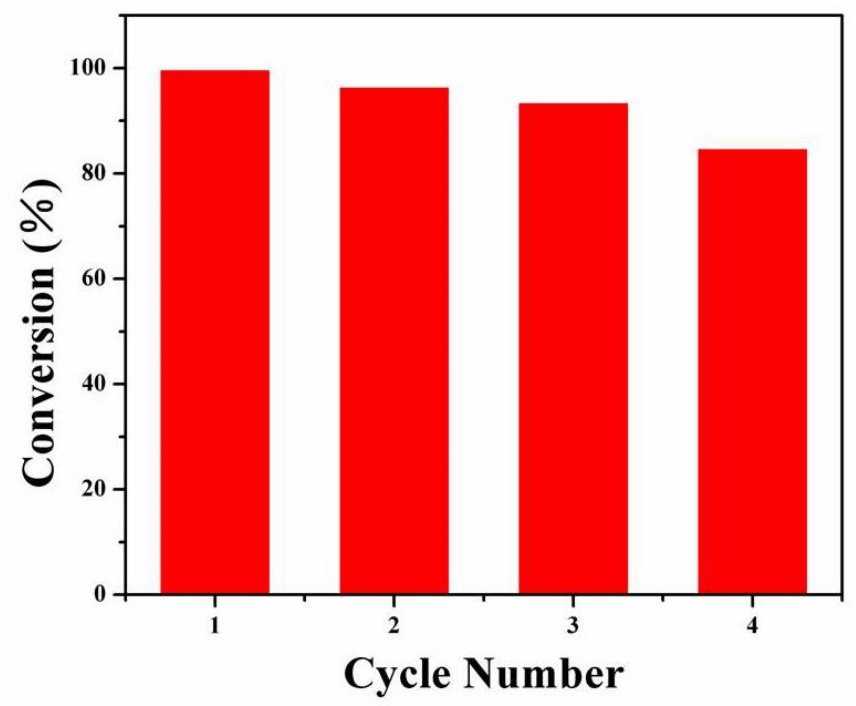
Figure 10. Reusability of the rGO/CoPt/Ag nanocomposite catalyst for the 4-NP reduction.